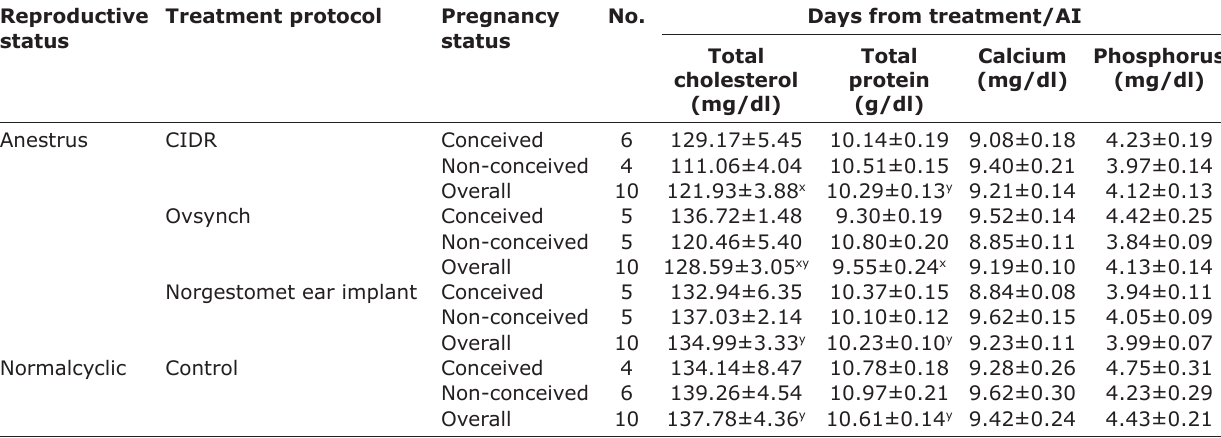
Table-3: Mean values of plasma protein, cholesterol, calcium and phosphorus concentrations in normal cyclic and anestrus cows under various estrus induction protocols. Reproductive Treatment status